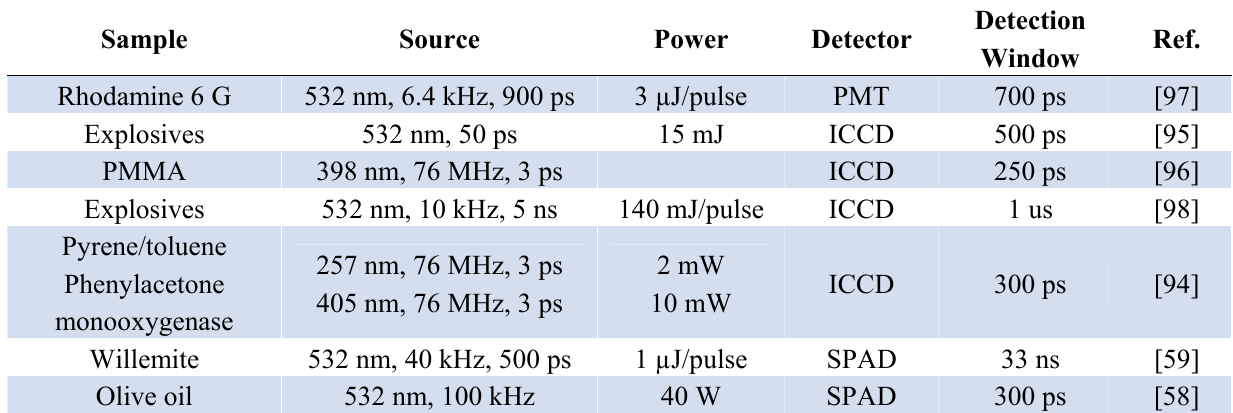
Table 6. Recently developed time-gated Raman systems.